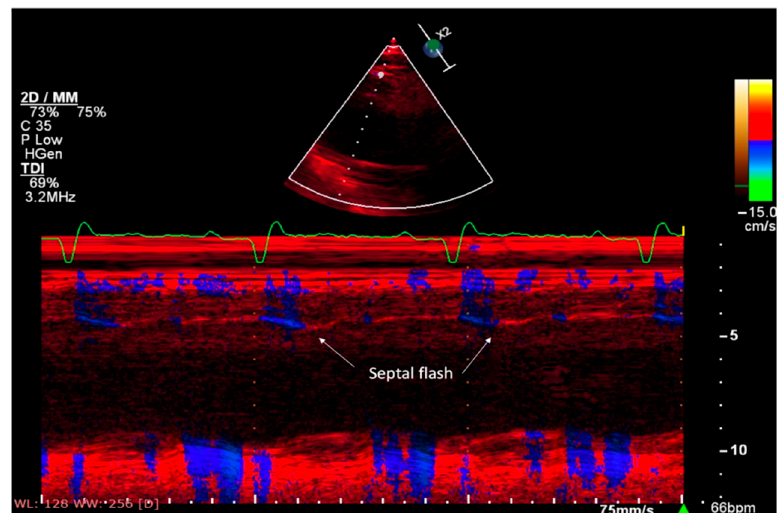
Figure 1. Septal flash in a patient with DCM, candidate for CRT (authors’ personal collection). Apical rocking: Apical rocking, a movement identified in the apical